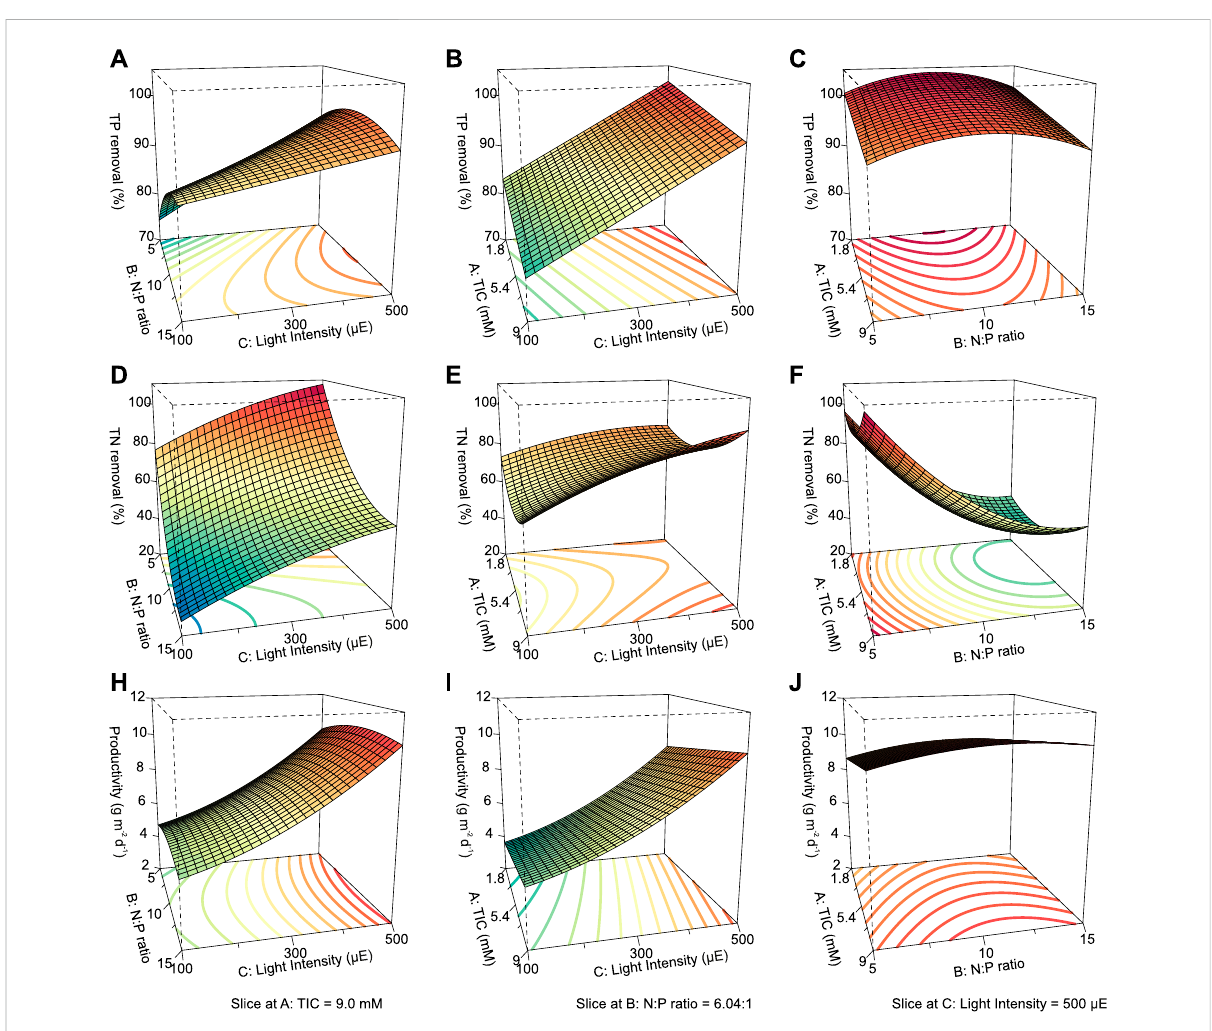
FIGURE 4 . 3D response surface and contour plots visualizing the interactive effects between the TIC concentration, N:P ratio, and light intensity for ATS performance.TPremoval,TNremoval,andbiomassproductivityareshownasafunctionofN:Pratiovs.lightintensityata fi xedTICconcentrationof 9.0 mM (A,D,H) ; TIC concentration vs. light intensity at a fi xed N:P ratio of 6.04:1 (B,E,I) ; TIC concentration vs. N:P ratio at a fi xed light intensity of 500 μ mol photons m − 2 s − 1 (C,F,J) , respectively. TIC, total inorganic carbon; N:P, nitrogen-to-phosphorus ratio; TP, total phosphorus; TN, total